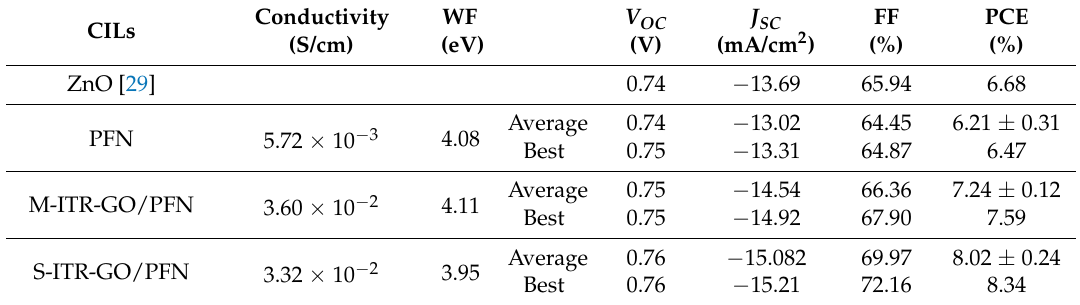
Table 1. Detailed characteristics of organic solar cells (OSCs) based on various cathode interlayers (CILs). Average values and standard deviations are deduced from 20 devices.